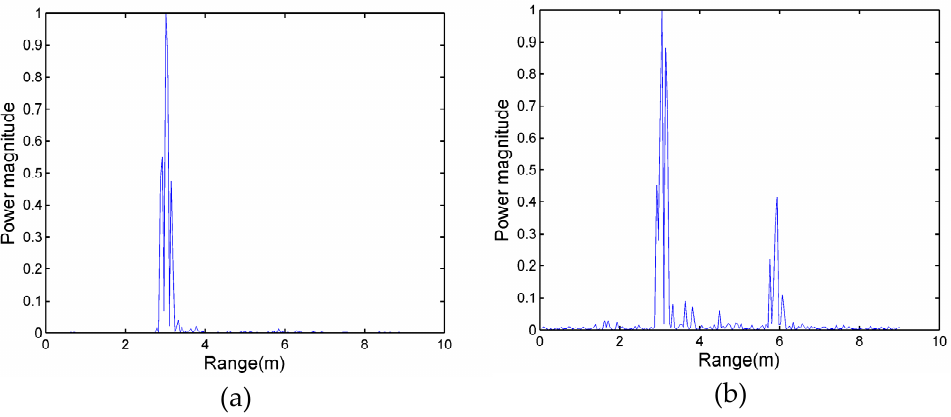
Figure 4. ( a ) The power spectrum of two targets with a shadowing effect; and ( b ) the power spectrum of two targets with no shadowing effect.